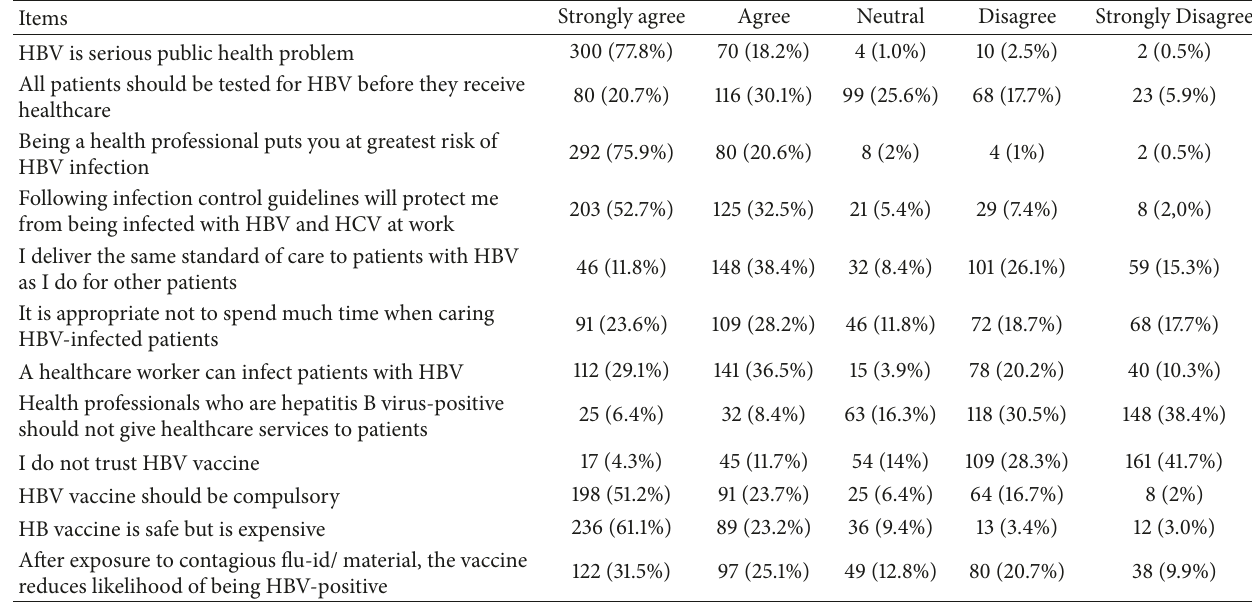
Table 2: Attitude of health professional towards hepatitis B infection and its vaccination, AHMC, Ethiopia, in 2017. Items